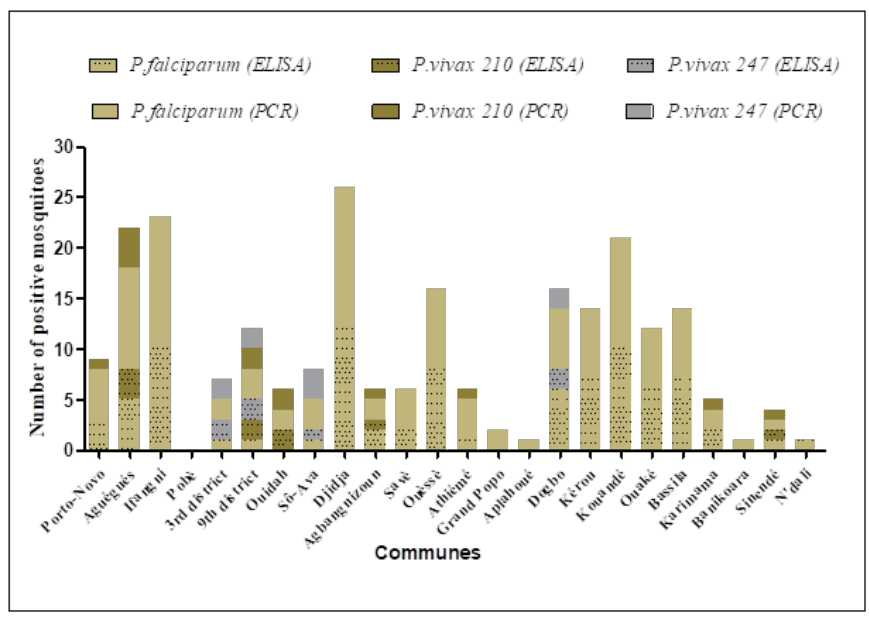
Figure 3. Number of P. falciparum , P. vivax 210 and P. vivax 247 sporozoite positive mosquitoes detected through PCR and CSP ELISA tests in all surveyed communes.